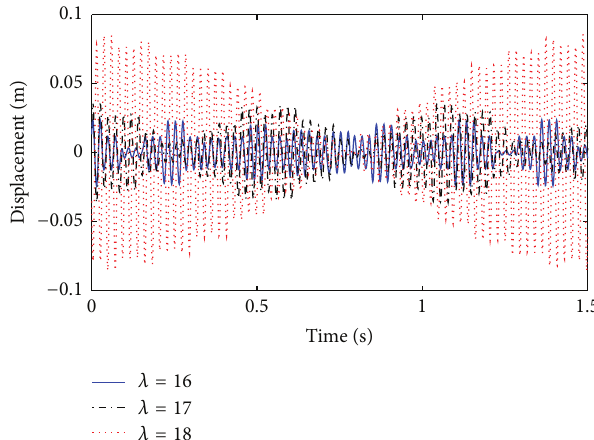
Figure 4: Vibrations imposed by boundary conditions with polyg- onal action at the head support.